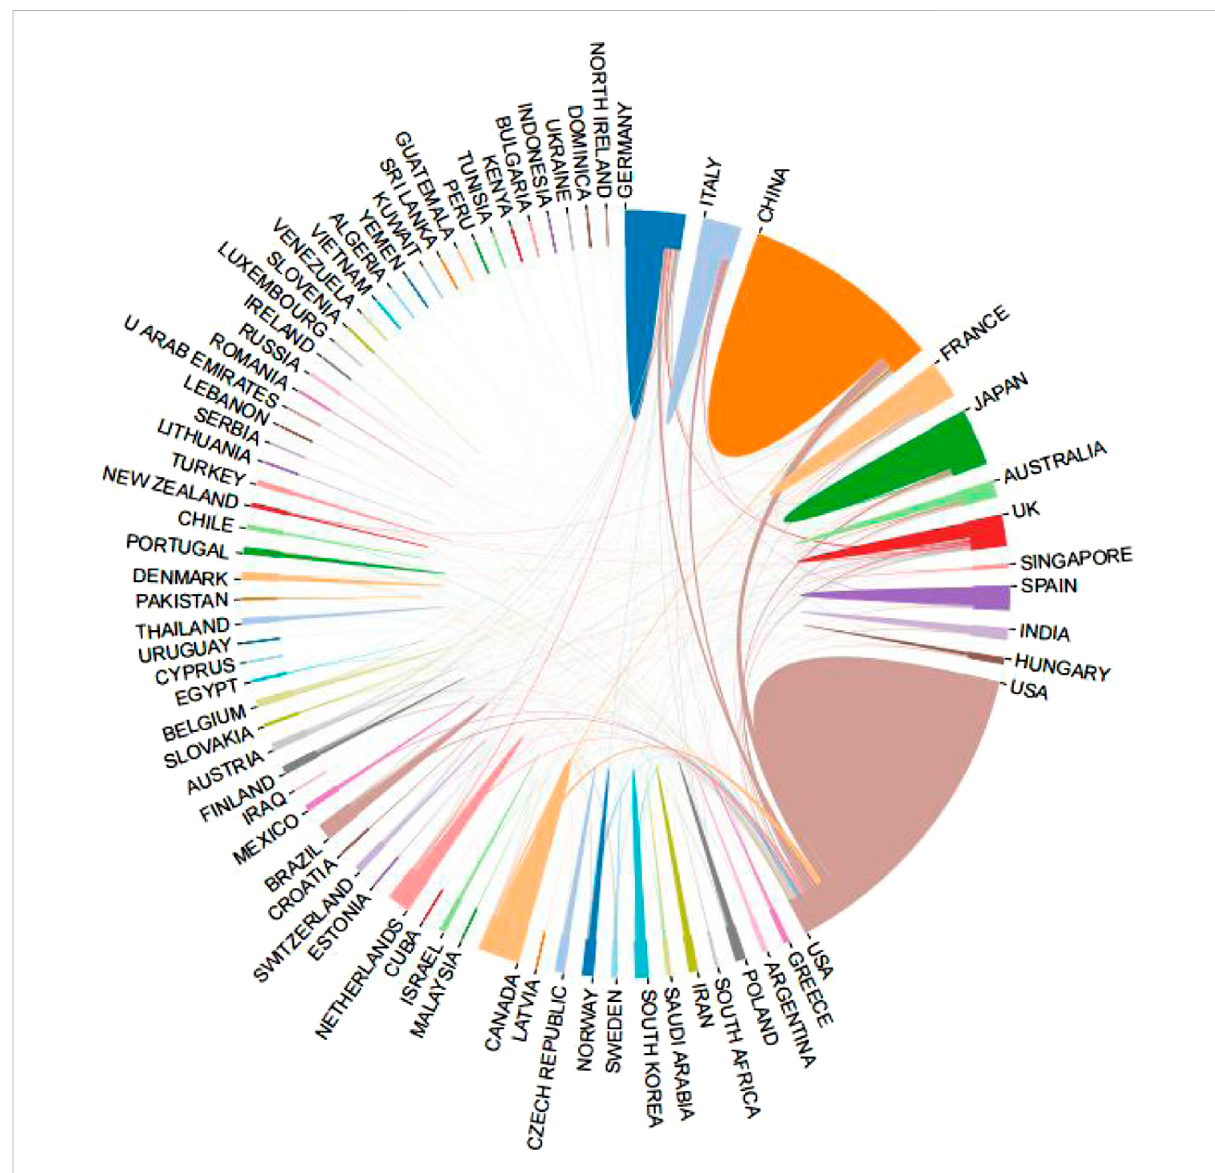
FIGURE 4 International collaboration between